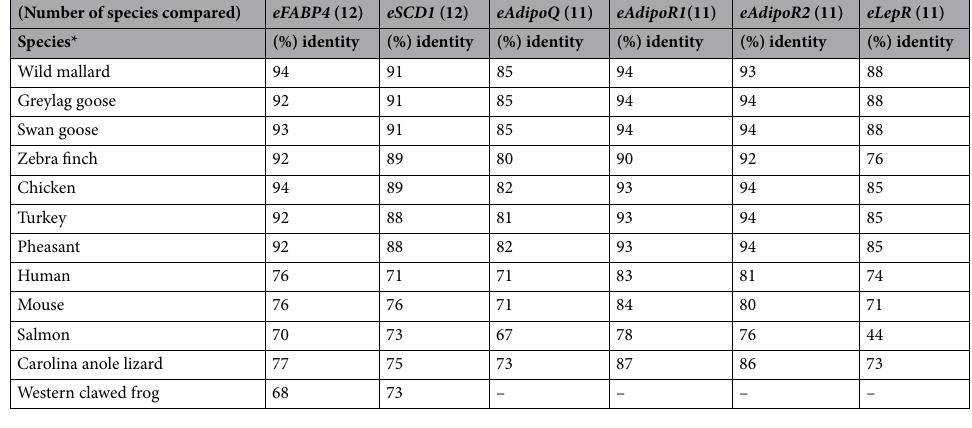
Table 4. Nucleotide sequences identities and similarities of FABP4 , SCD1 , AdipoQ , AdipoR1 , AdipoR2 and LepR between emu ( D. novaehollandiae ) and other animal species*. *Wild mallard ( A. platyrhynchos ), Greylag goose ( A. anser ), Swan goose ( A. cygnoides ), zebra finch ( T. guttata ), chicken ( G. gallus ), turkey ( M. gallopavo ), pheasant ( P. colchicus ), human ( H. sapiens ), mouse ( M. musculus ), salmon ( S. salar ), Carolina anole lizard ( A. carolinensis ), Western clawed frog ( X. tropicalis